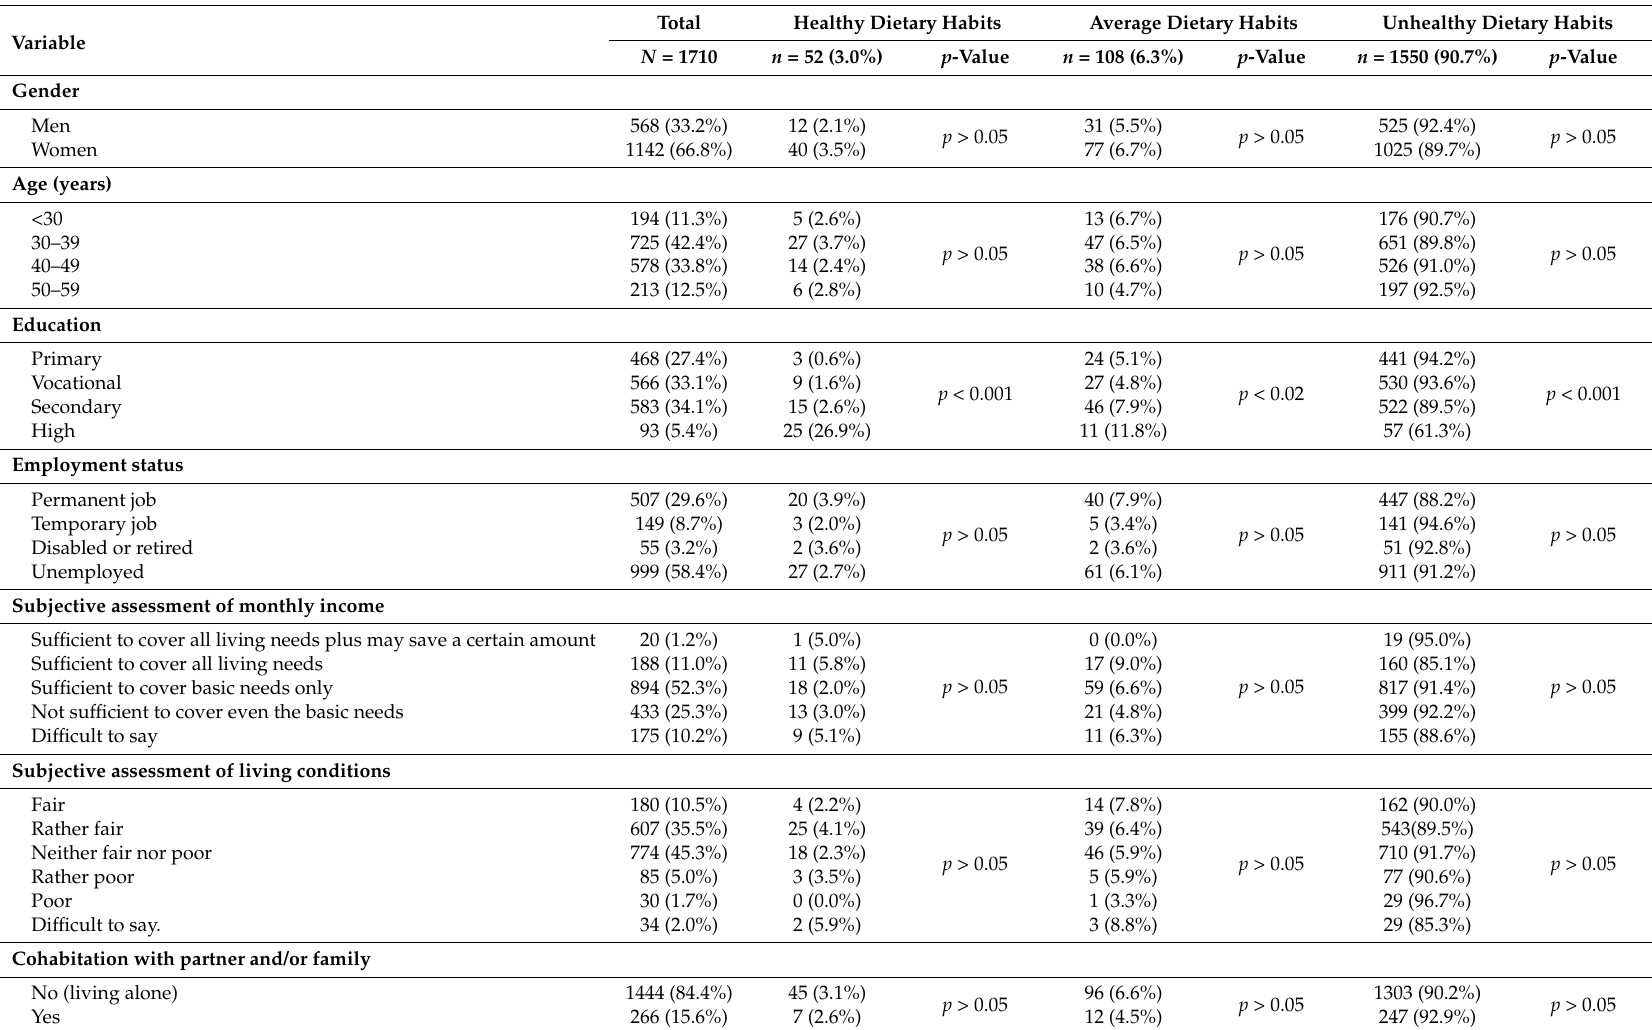
Table 4. Categories of Dietary Quality Score and the study